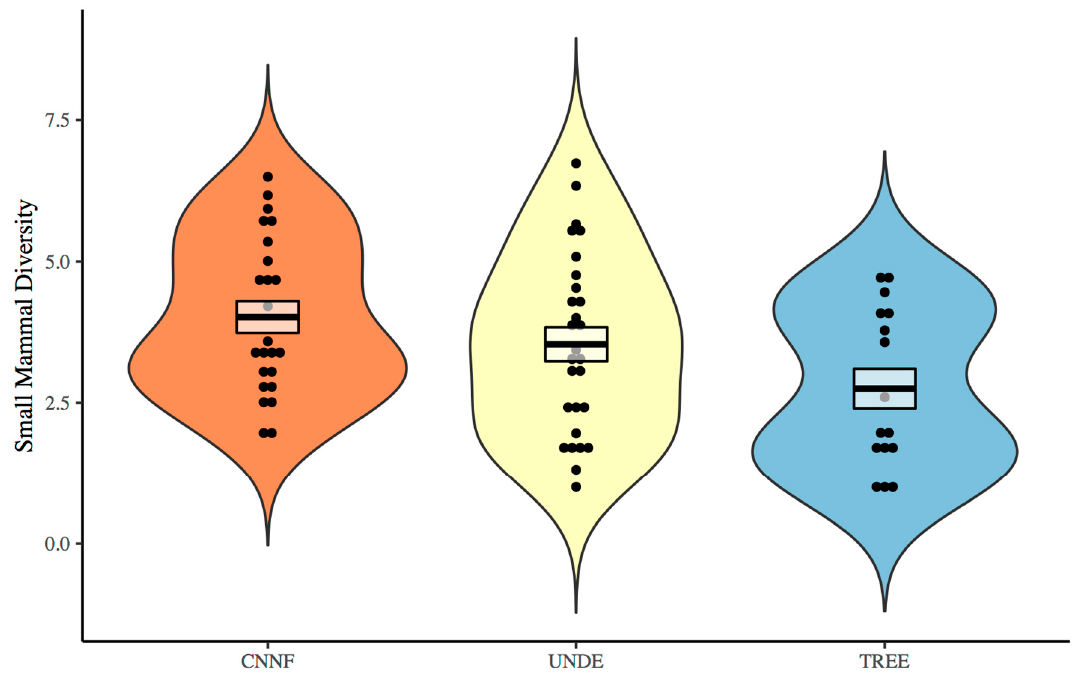
Figure 3. Violin plot of subplot small mammal diversity for sites CNNF, UNDE, and TREE; mean small mammal diversity (black horizontal bars) with 95% confidence intervals (white boxes) and range of small mammal diversity at each of the subplots (black dots) are presented.